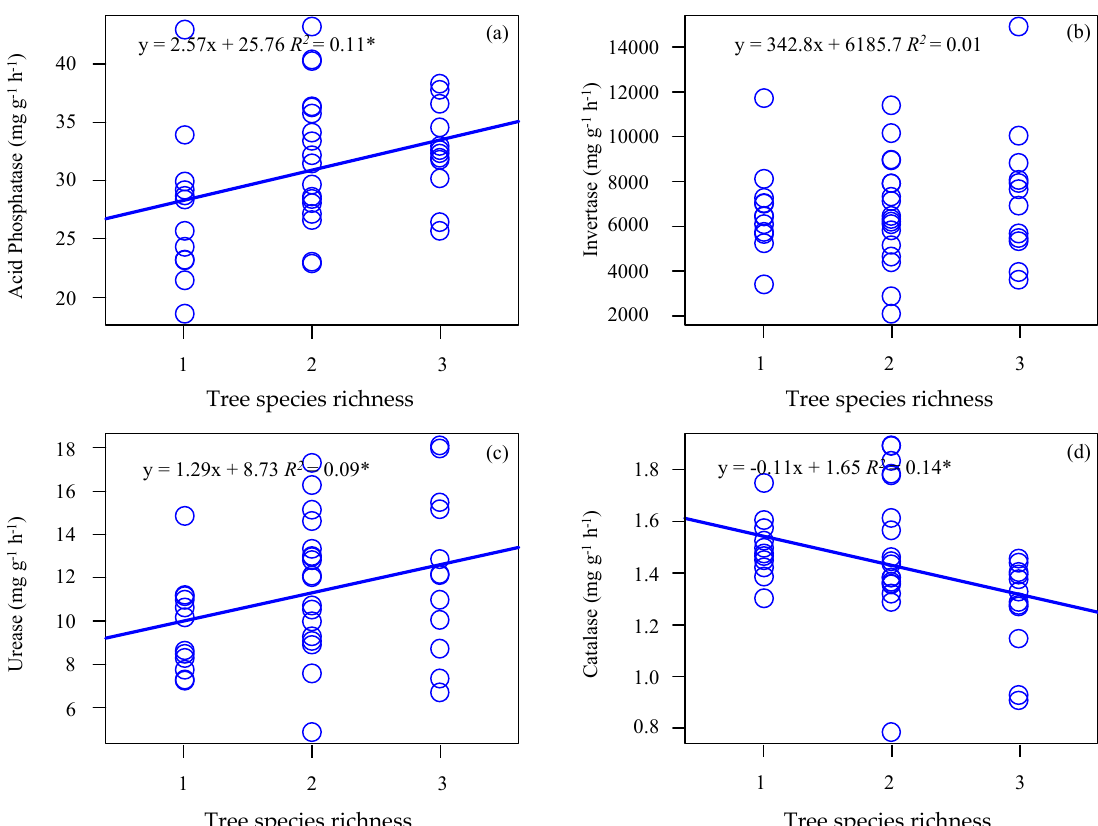
Figure 6. Correlation between soil enzyme activity and tree species richness in tree clusters varying in tree species richness, from one, two, and three tree species combinations in subtropical evergreen broad-leaved forests. ( a ) acid phosphatase, ( b ) invertase, ( c ) urease, ( d ) catalase. Statistical significance is denoted by * p < 0.05.